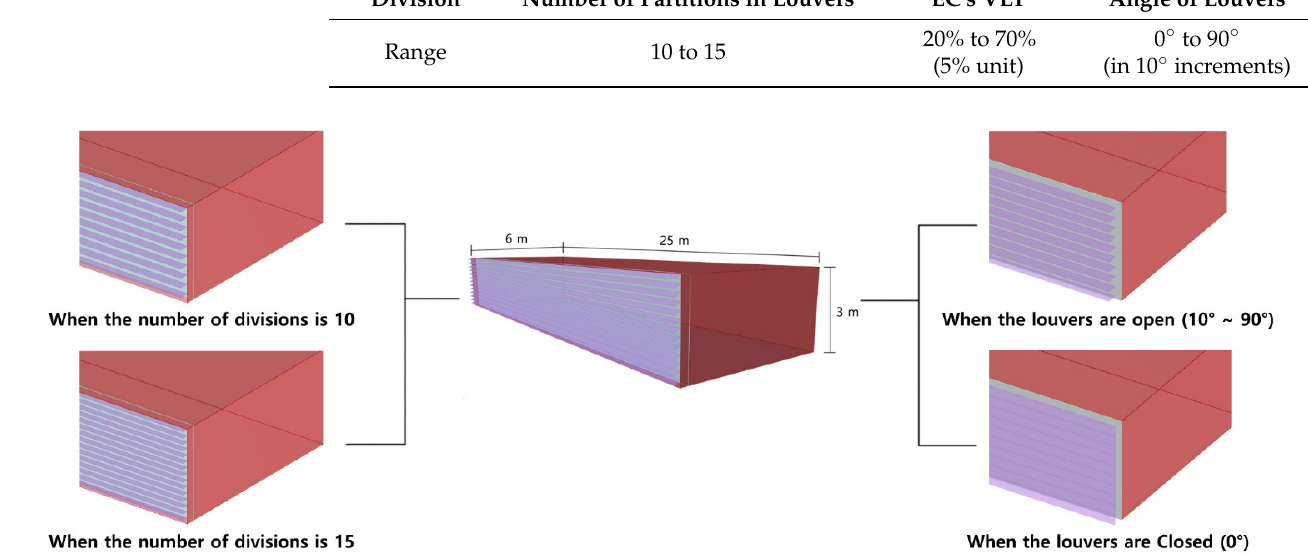
Figure 4. Configuration of analysis model.